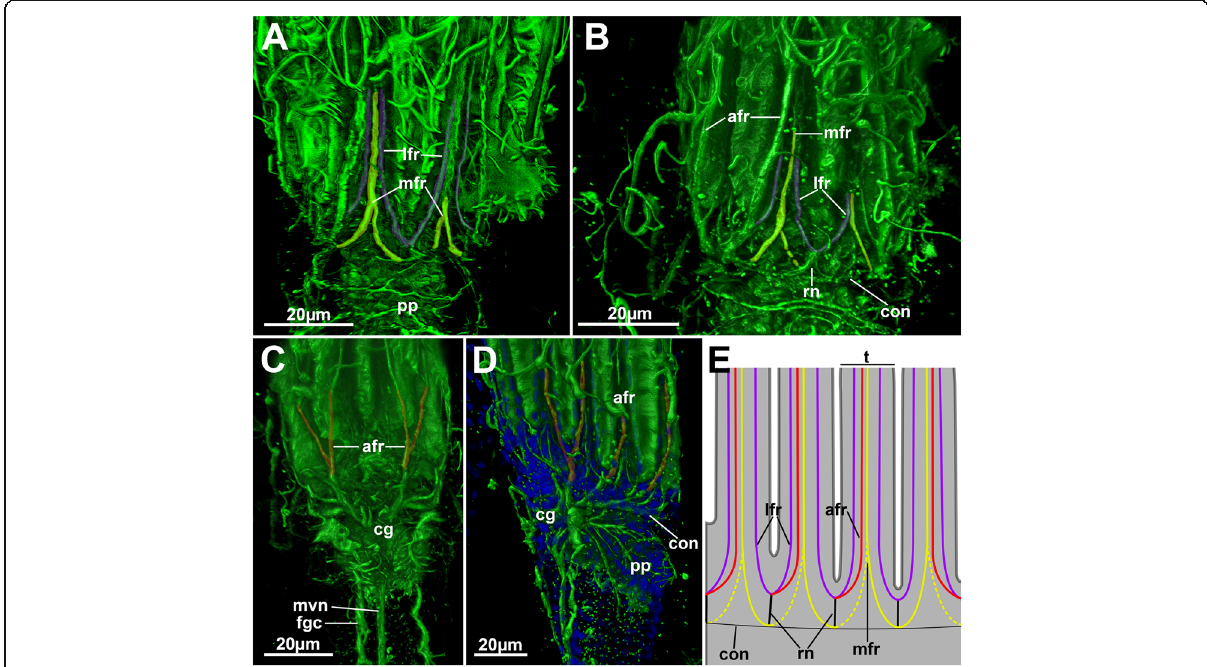
Fig. 11 Tentacle innervation of Hypophorella expansa . Acetylated alpha tubulin staining (green), nuclei (blue), CSLM, volume rendering. a , b Two specimens showing the lophophoral base and highlighted medio-frontal neurite bundles (yellow) and latero-frontal ones (purple). c Anal view of the lophophoral base showing the two abfrontal neurite bundles (red) that split to innervate two adjacent pairs of tentacles above the ganglion. d Oblique view showing the abfrontal neurite bundles (red) on the anal and lateral sides of the lophophore. e Schematic drawing of the main tentacle neurite bundle branching. Latero-frontal neurites in purple, medio-frontal neurites in yellow and abfrontal neurites in red. Note that distinct asymmetries are present in the medio-frontal tentacle neurite bundle (indicated by dashed lines). Abbreviations: afr – abfrontal neurite bundle, cg – cerebral ganglion, con – circum-oral nerve ring, fgc – foregut ciliation, lfr – latero-frontal neurite bundle, mfr. – medio-frontal neurite bundle, mvn – medio-visceral neurite bundle, pp. – peripharyngeal plexus, rn – radial